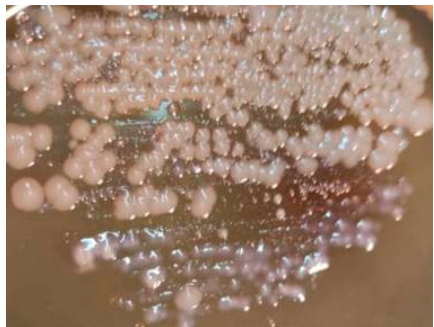
Figure 5. “Pseudolysogenic colonies” after 3 days of incubation—the material seeded from the lysis zone of phage phiKZ after overnight incubation yields many small colonies of bacteria. After further incubation (1–2 days), colonies slightly increase in size and, due to the content of numerous mature phage particles, acquire a blue shade.